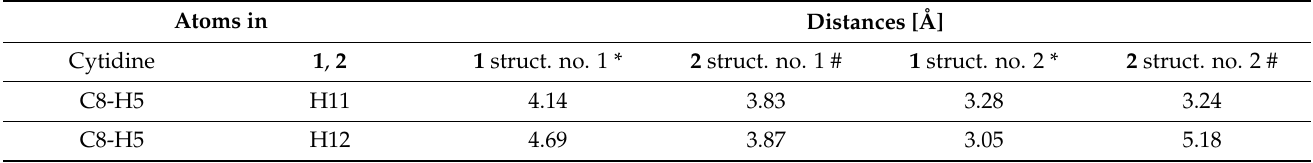
Table 8. Internuclear distances in complexes of an ultimate G1-C8 base pair of octamer 3 and compounds 1 and 2 . Atoms in Distances [Å]